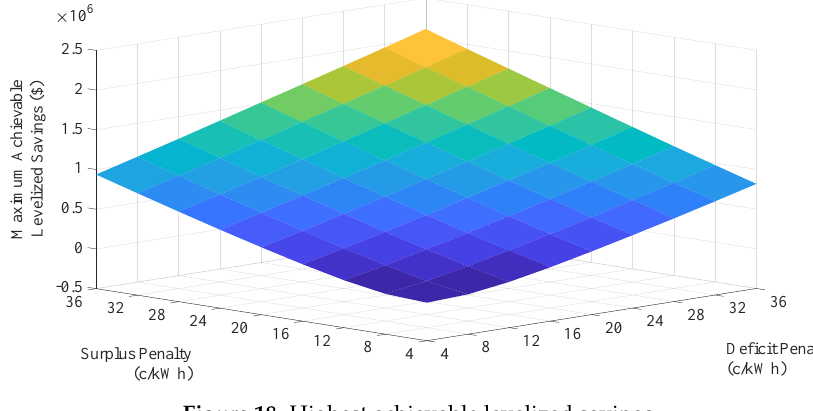
Figure 18. Highest achievable levelized savings. Table 6. Maximum achievable levelized savings in million $; penalties are in c/kWh.